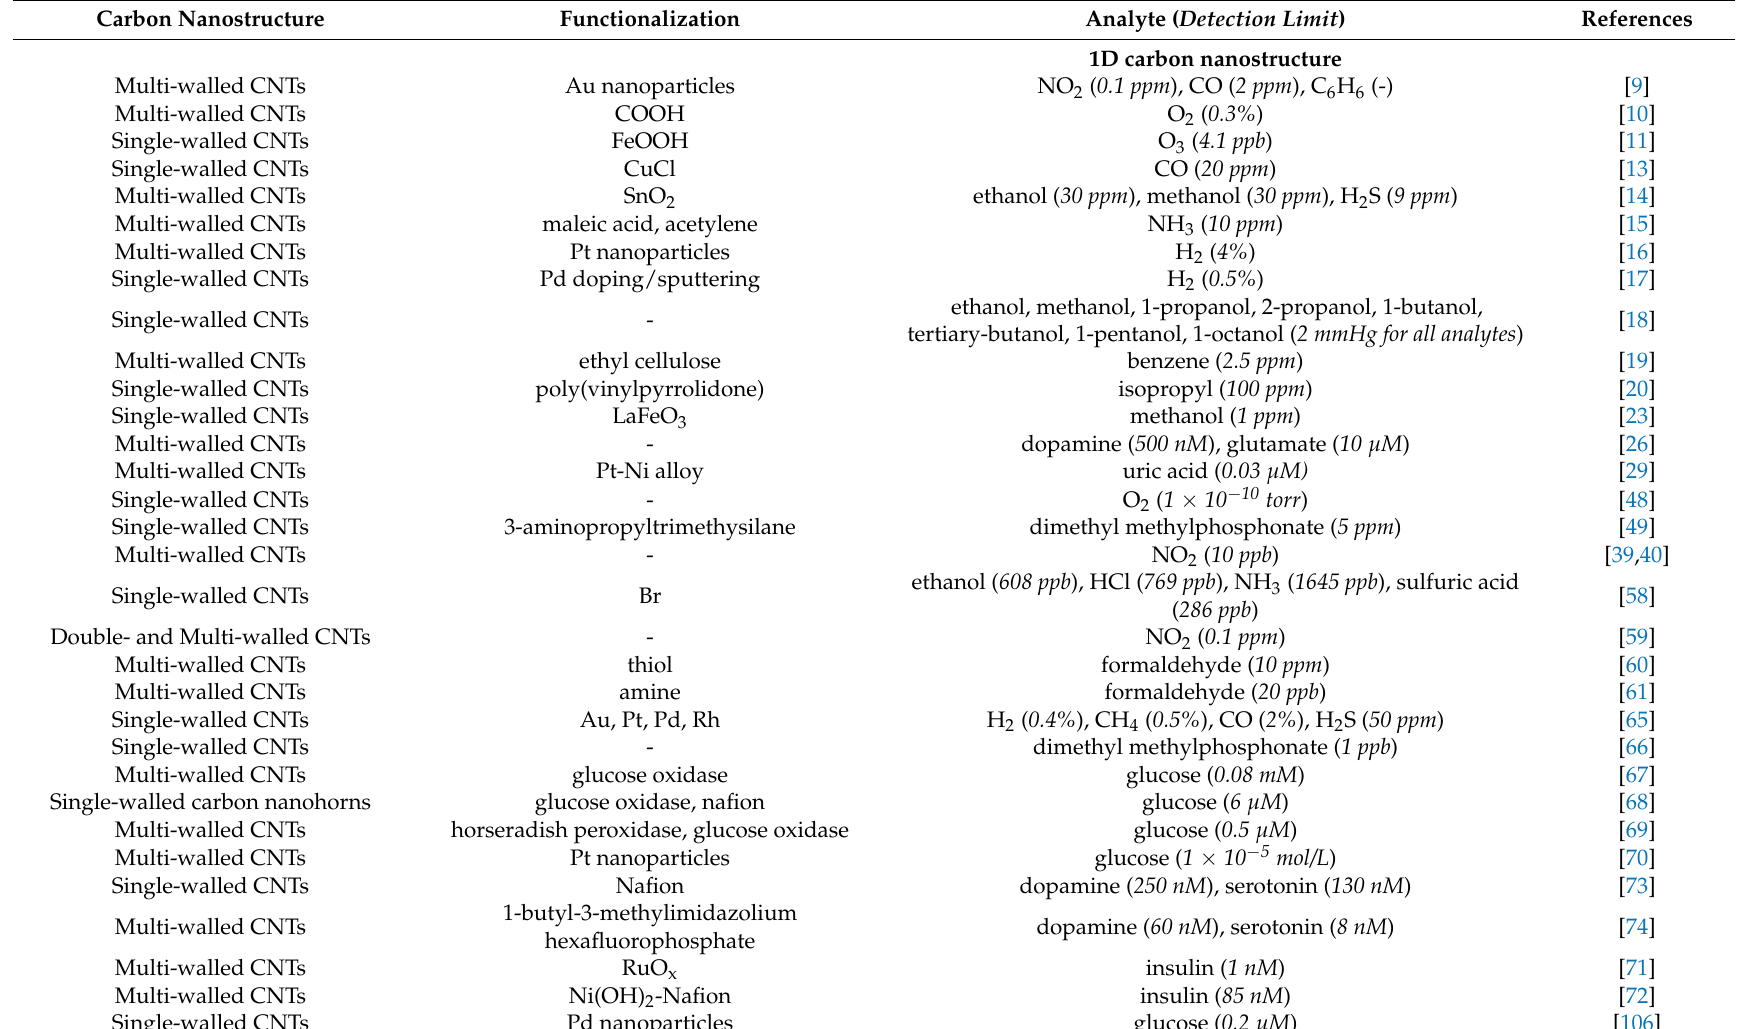
Table 1. Carbon nanostructures used as sensors, their functionalization and corresponding analyte discussed within this